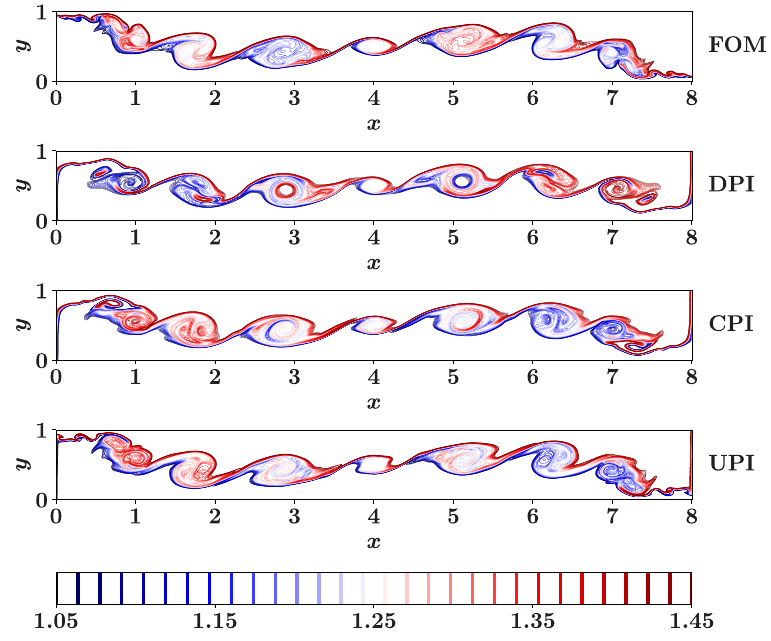
Fig 6. Final temperature fields as obtained from different ROM-FOM coupling approached, compared to the FOM solution. We note that the PCI becomes infeasible for higher dimensional systems.